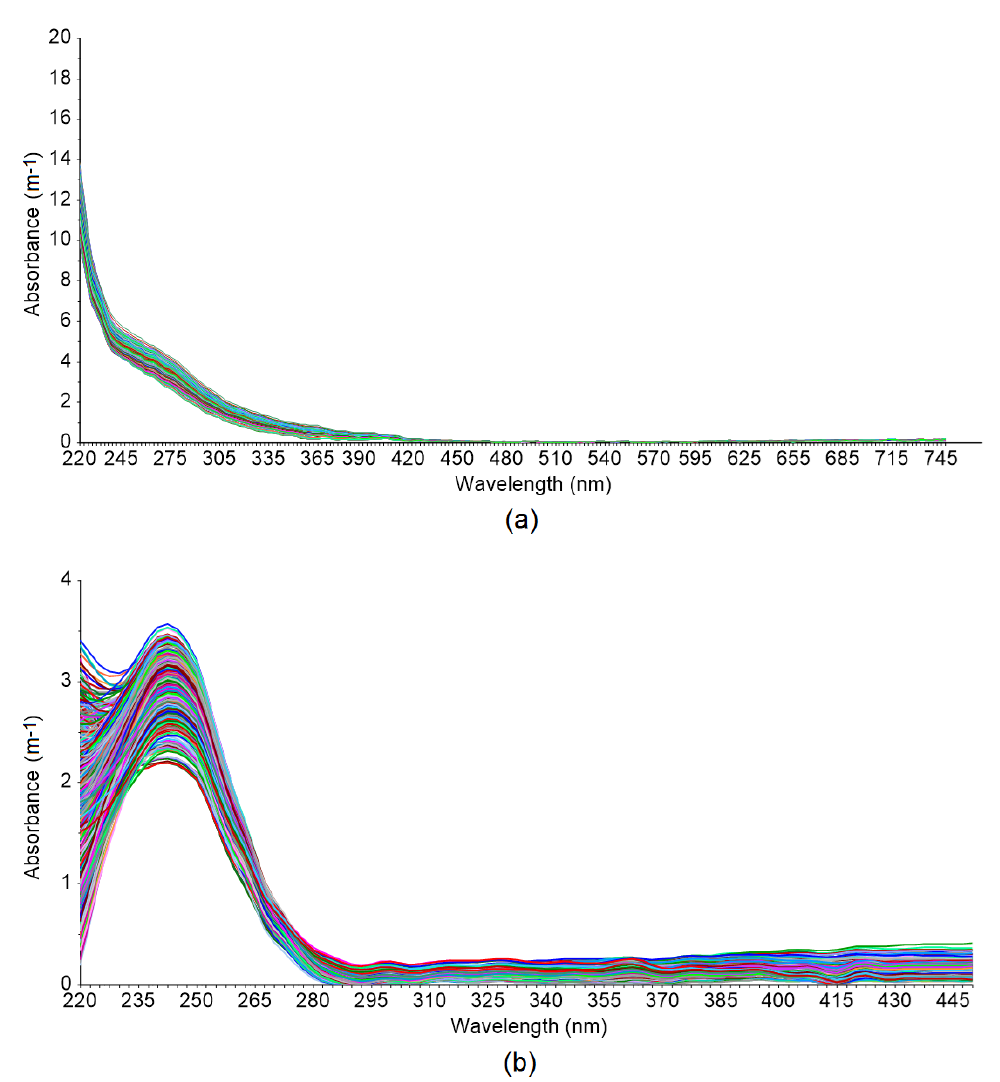
Figure A4. ( a ) Estimated pre chloraminated spectra from DOC and NO 3 -N using polynomial regression and ( b ) estimated NH2Cl spectra (these spectra were obtained by subtracting Figure A4a spectra from Figure A2b spectra. For better visibility, up to 445 nm is shown here. The remaining region is flat). Table A1. R-square and RMSE values in polynomial model fitting using NO 3 -N and DOC and absorbance at various wavelengths.